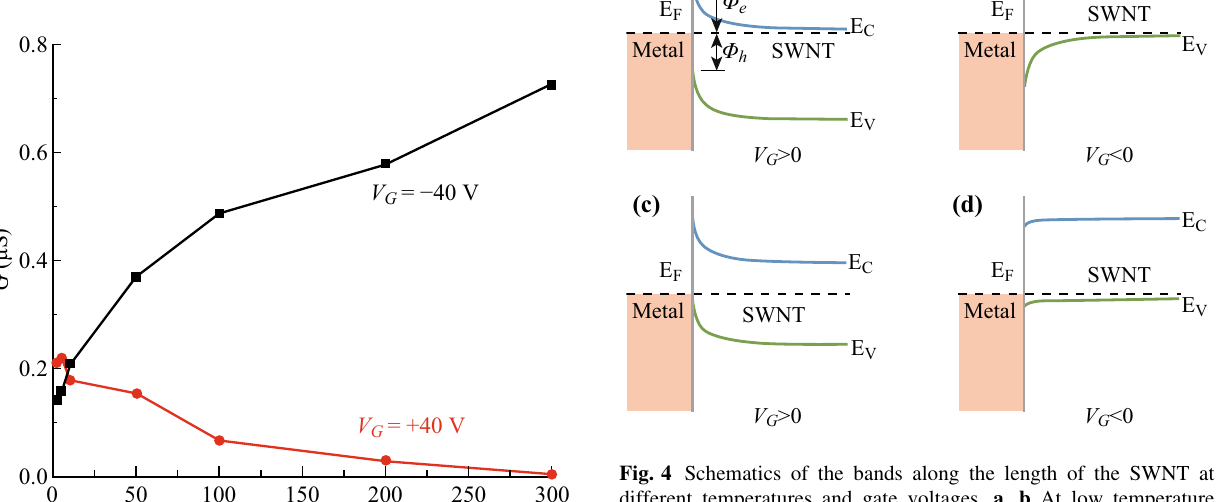
Fig. 3 Drain conductance ( G ) at V G = - 40 V (black) and ? 40 V (red) as a function of temperature